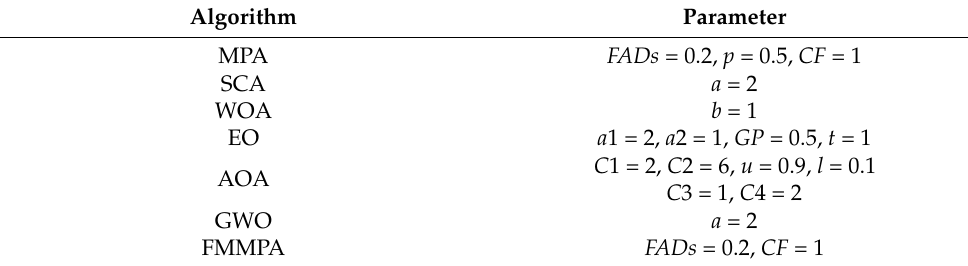
Table 2. Algorithm parameter